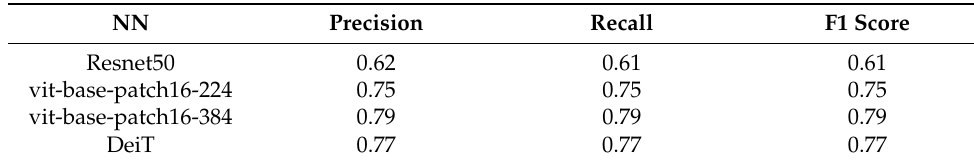
Table 2. The metrics of the different DL models.